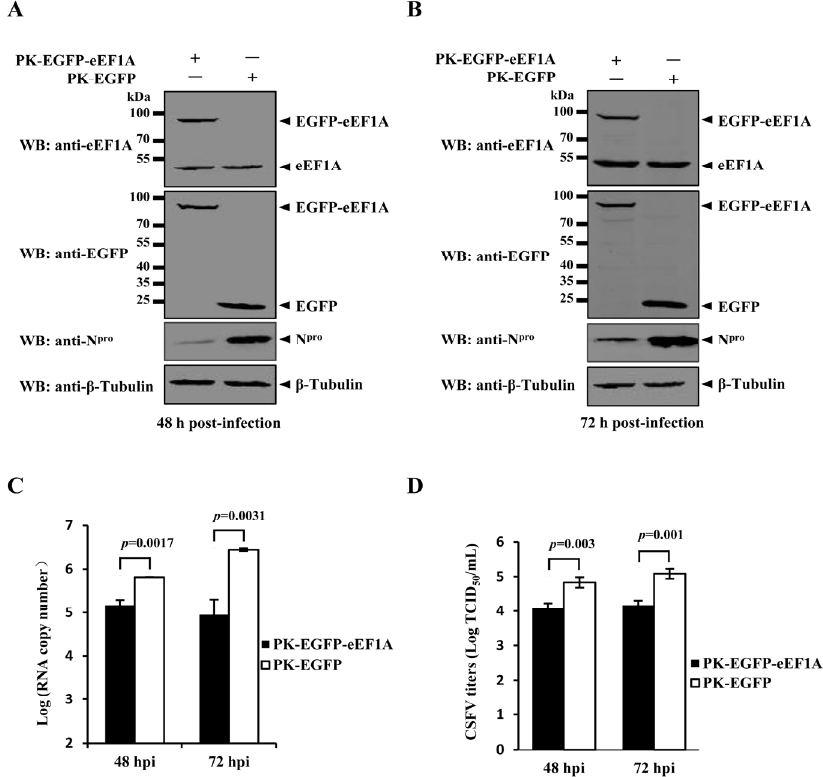
Figure 3. Overexpression of eEF1A suppresses the CSFV growth. ( A and B ) Western blotting analysis of overexpressed EGFP-eEF1A and CSFV N pro . PK-15 cells were